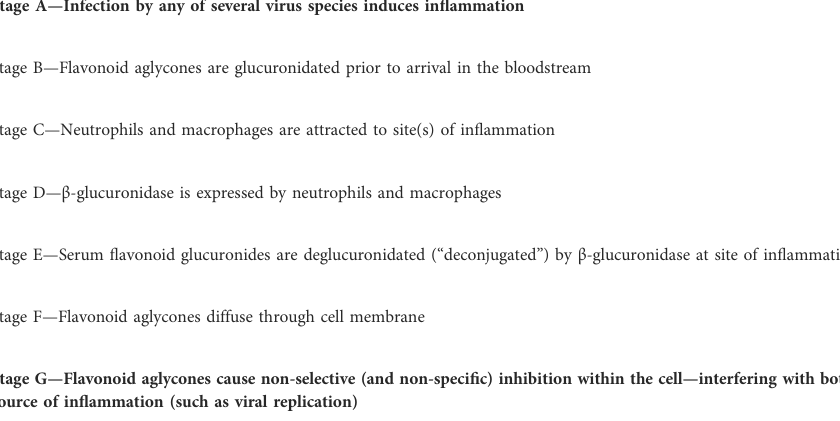
TABLE 2 Proposed deglucuronidation-based antiviral mechanism. Stage A — Infection by any of several virus species induces in fl ammation ↓